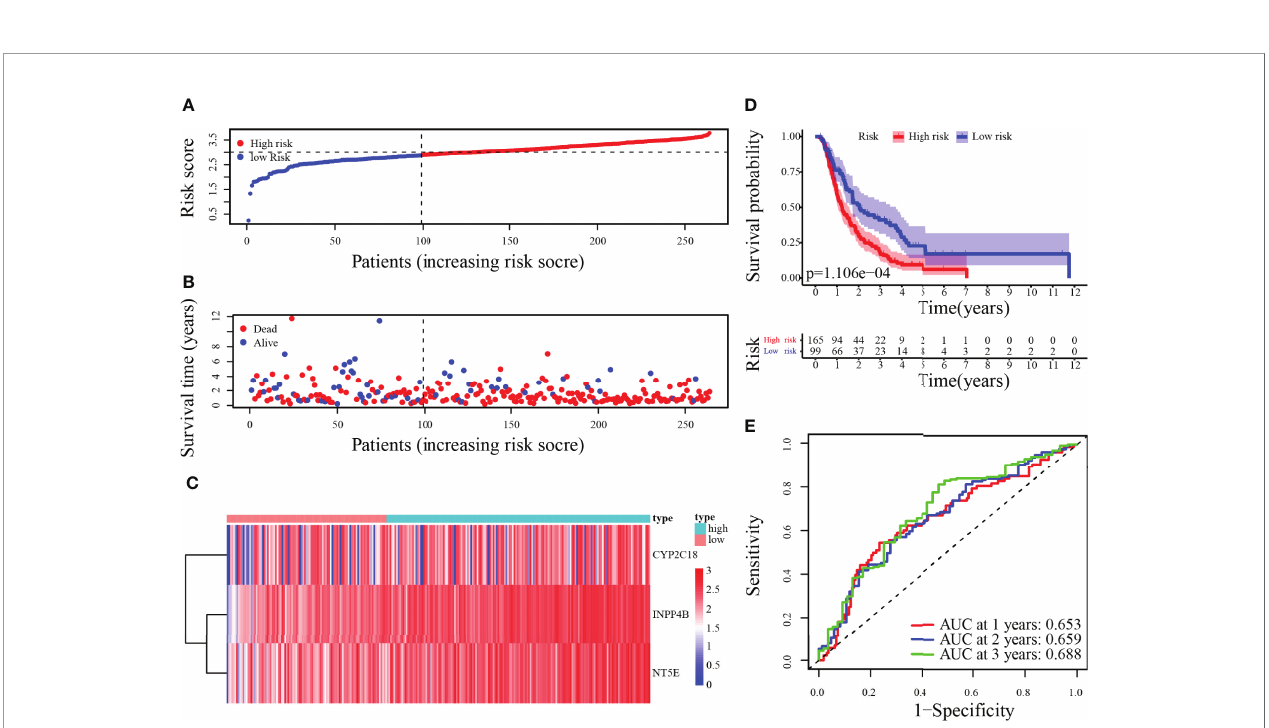
FIGURE 6 | Risk score analysis of 3-MRG prognostic signature in the validation cohort 1. (A – D) The risk score, survival status of PC patients, heatmap of the 3- MRG expression, and survival curves between low and high-risk groups are shown. (E) Time-independent ROC analysis of risk score for predicting the OS in the ICGC cohort (PACA-AU and